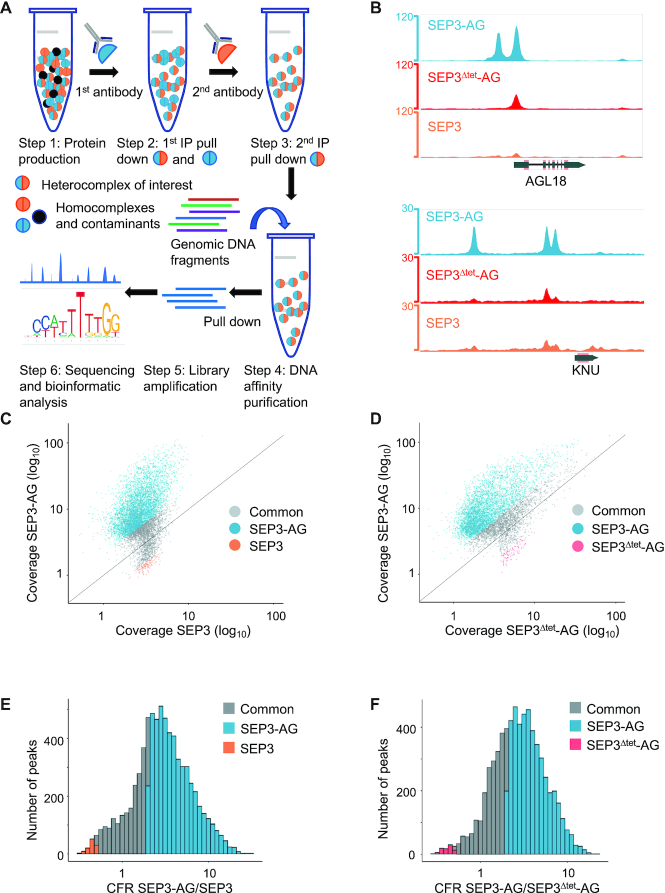
Seq-DAP-seq workflow and data analysis. (A) Schematic of the seq-DAP-seq protocol. Each TF or TF combination is expressed with a unique tag and purified by sequential pull-down using an appropriate antibody. Purified TF complexes are used for DNA-affinity purification and sequencing according to published protocols (21). (B) Integrated Genome Browser snapshot of SEP3–AG (blue), SEP3Δtet-AG (red) and SEP3 (orange) peaks from seq-DAP-seq showing complexes bind unique sites and common sites with varying intensity. Read count are shown on the y-axis. Gene names (KNUCKLES (KNU) and AGAMOUS-LIKE-18 (AGL18)) are given on the x-axis. (C) Comparison of SEP3–AG and SEP3 datasets. Each peak is shown as a color-coded dot, with SEP3–AG specific peaks in blue, common peaks in gray and SEP3 specific peaks in orange. Peaks were assigned as specific to a TF complex based on whether a given peak exhibited at least a 2-fold difference in normalized read coverage between datasets. (D) Comparison of SEP3–AG and SEP3Δtet-AG datasets with SEP3–AG peaks in blue, common peaks in gray and SEP3Δtet-AG specific peaks in pink. Peak assignment as per (C). (E) CFR (ratio of normalized peak coverage of SEP3–AG/SEP3), color-coded per (C). (F) CFR of SEP3–AG/SEP3Δtet-AG, color-coded per (D).